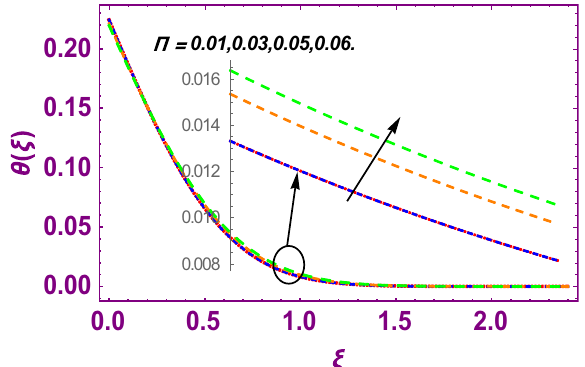
Figure 4. Effect of (cid:31) on θ(ξ) .